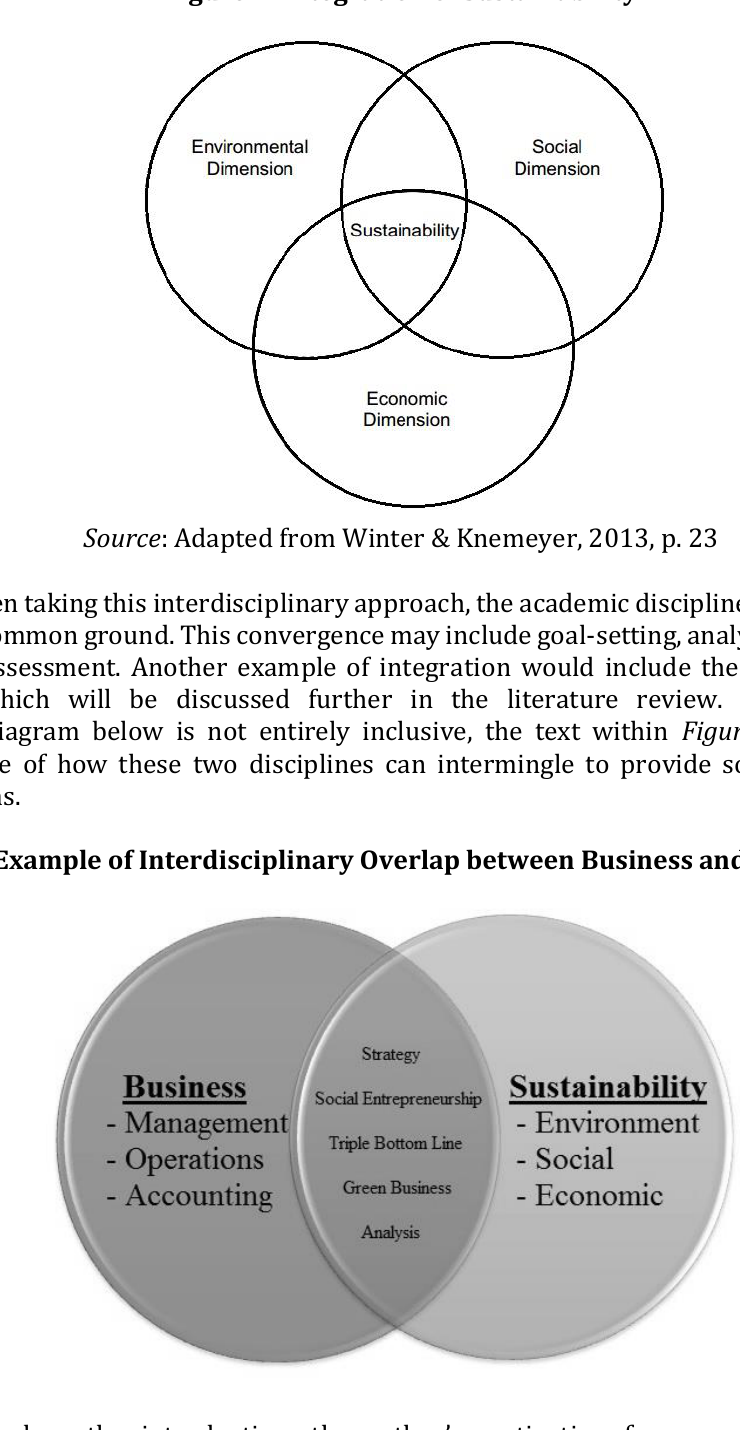
Figure 1: Integration of Sustainability